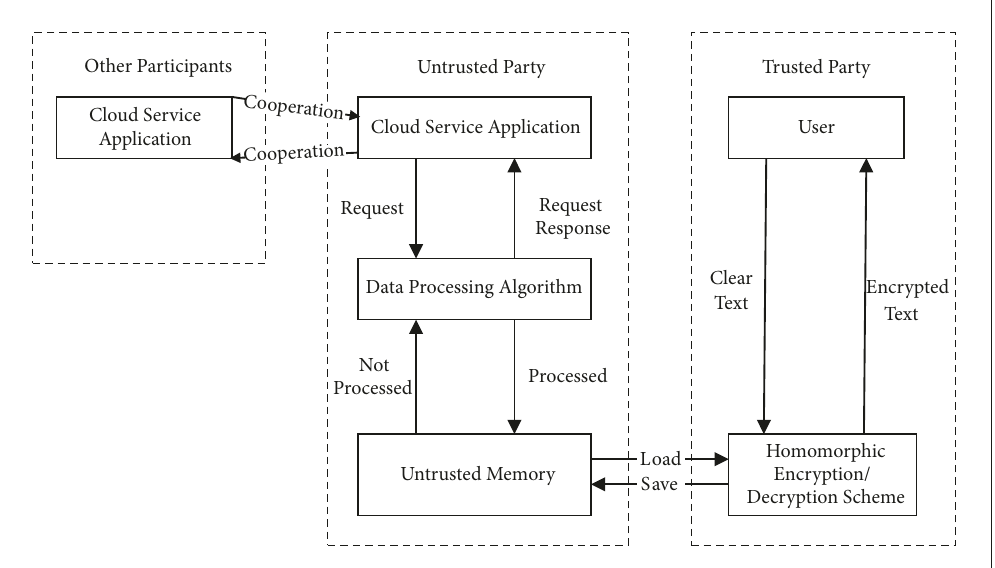
Figure 1: General application framework of fully homomorphic scheme.